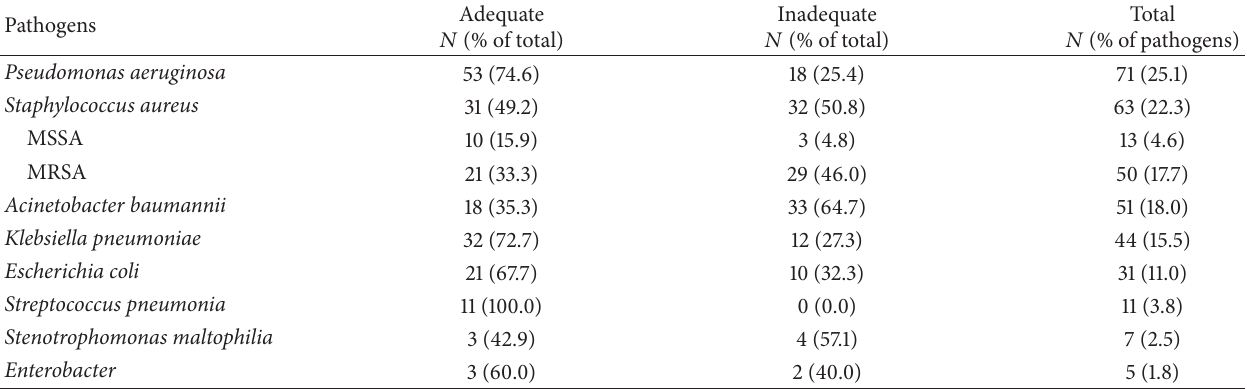
Table 2: Pathogens in severe pneumonia between adequate and inadequate antibiotic use.